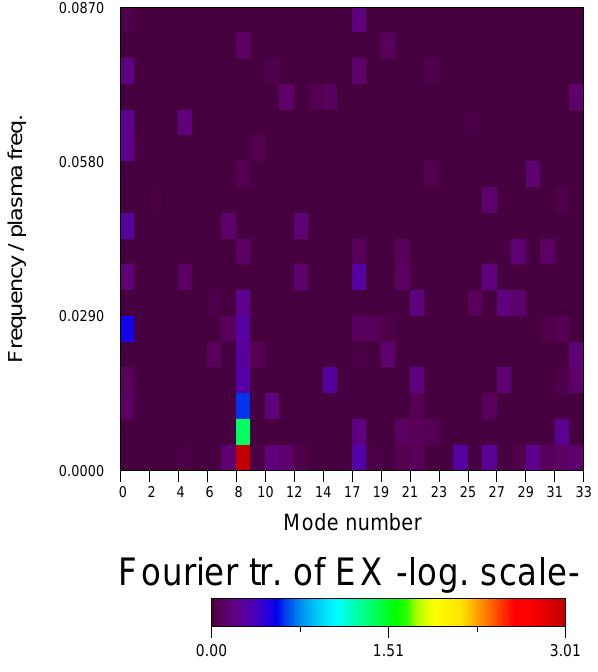
Fig. 7. AWC010 (two sinusoids). Space-time Fourier transform of E X (X,t) . The horizontal axis displays the spatial mode num- ber, and the vertical axis represents the frequency. The colour scale shows the logarithm of the mode